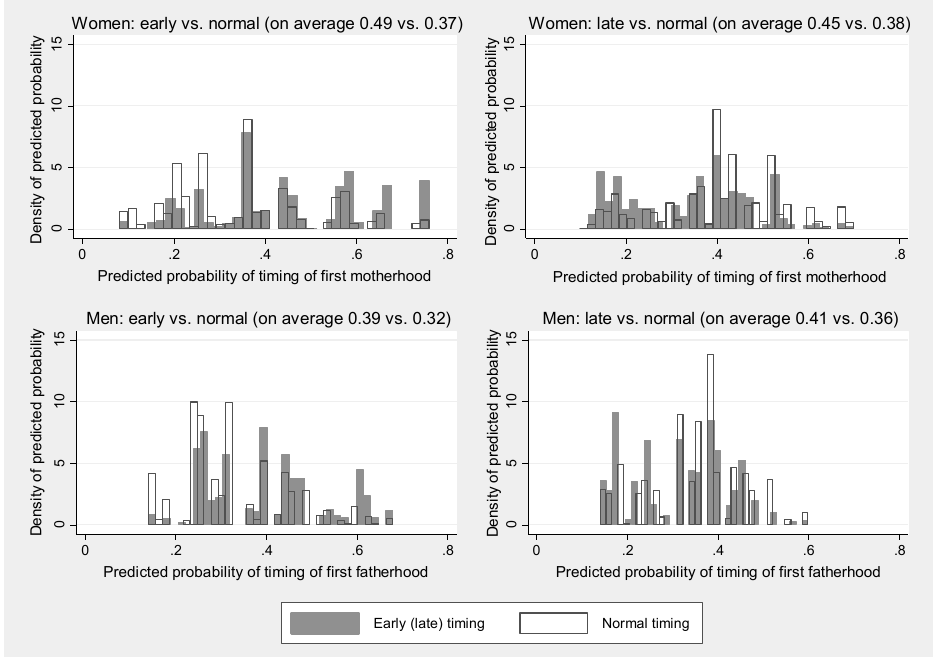
Figure 1 : Predicted probabilities of early and late parenthood, by sex and timing Women: early vs. normal (on average 0.49 vs. 0.37) Women: late vs. normal (on average 0.45 vs. 0.38)